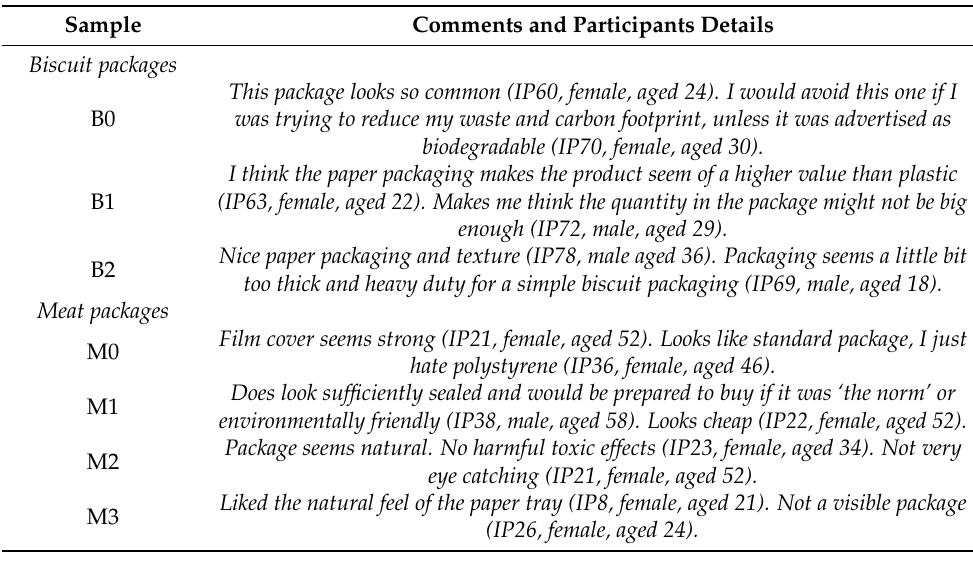
Table 8. Examples of participants’ comments (one positive and one negative comment) relating to the various